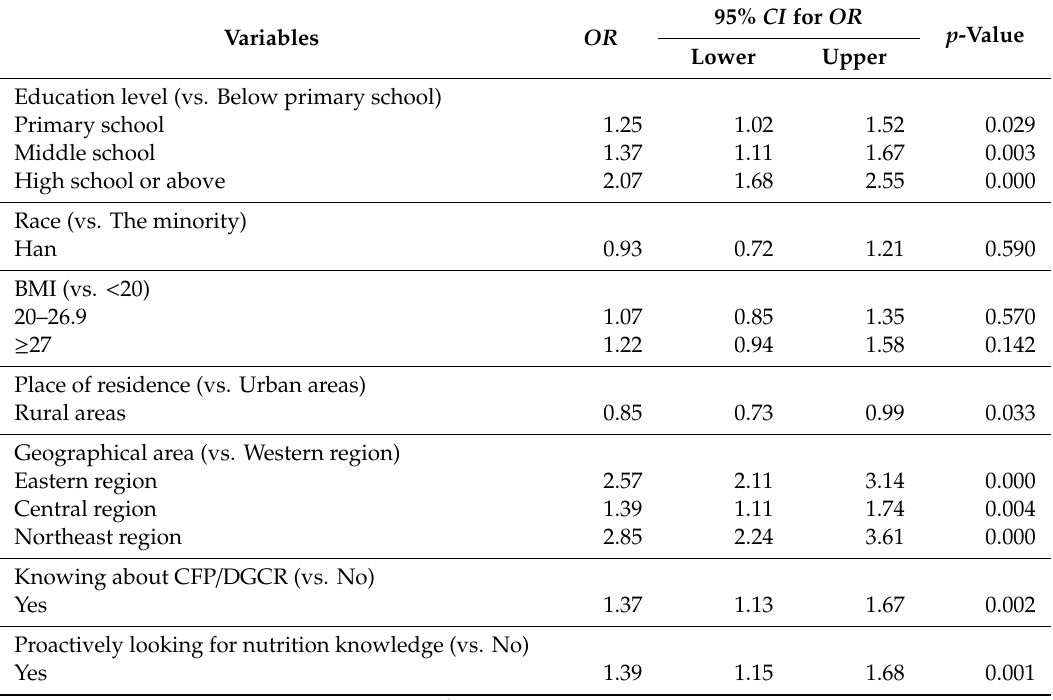
Table 4. Multi-factor logistic regression analysis testing the factors associated with dietary knowledge literacy. Variables OR